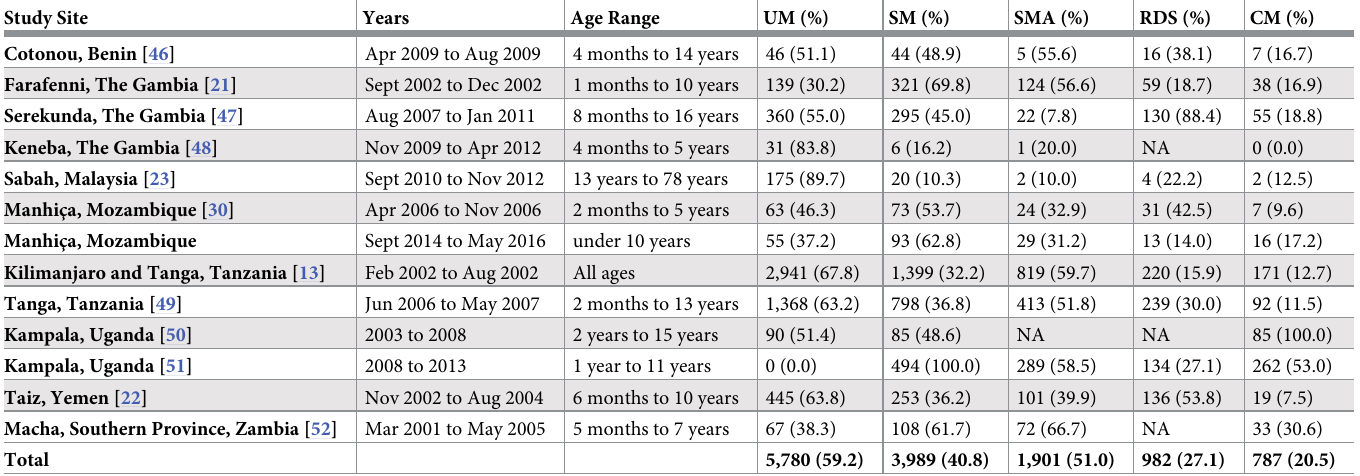
Table 1. Characteristics of studies used in IPD meta-analysis. Table includes study site, study period, age ranges included, and frequencies and percentages of uncom- plicated and SM groups amongst the study sample. Percentages with a given phenotype amongst severe cases are shown in brackets and omit missing values for that pheno- type. The denominator only includes those who were assessed for that phenotype. ‘NA’ entries indicate that information on the phenotype in that study was not collected (for example, data on RDS were not collected in the Zambian study). Percentages may add up to more than 100% because the same study subject may present with more than 1 phenotype. This table excludes 196 individuals (2% of total participants) who were classified as severe in the original studies but did not meet the criteria for severe disease in the IPD analysis. See S2 Table for other severe disease phenotypes. See S4 Table for SM frequencies from the UK study, which was not used in the pooled analysis. Abbreviations: CM, cerebral malaria; IPD, individual-participant data; RDS, respiratory distress syndrome; SM, severe malaria SMA, severe malarial anaemia; UM, uncomplicated